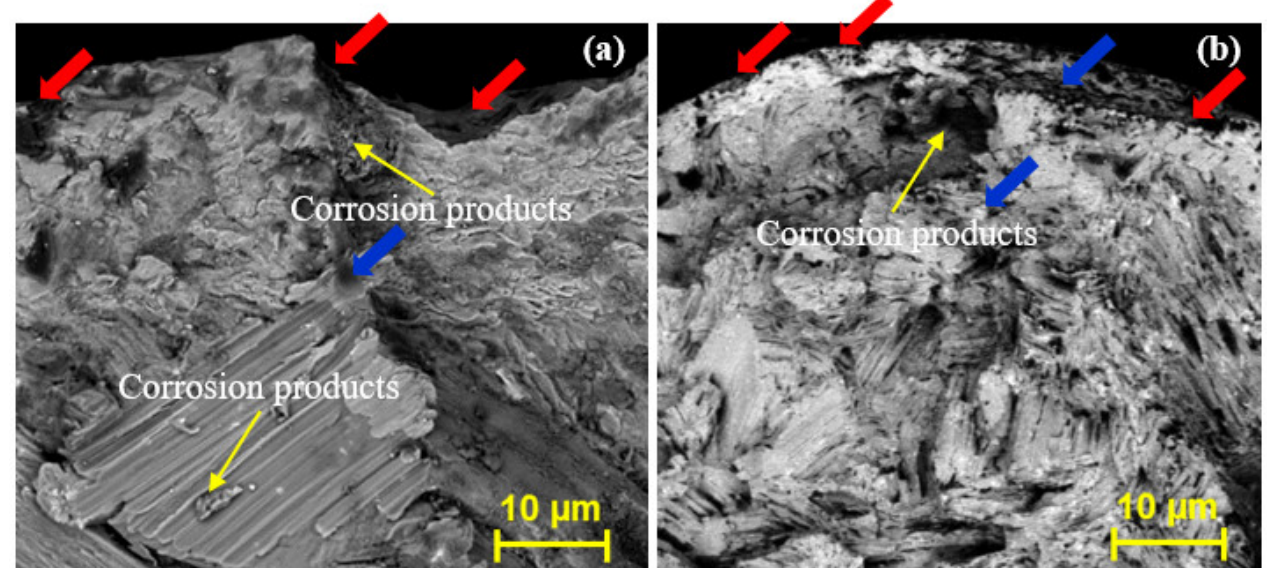
Figure 7. Fatigue fracture surfaces show the crack initiation and propagation in the ( a ) as-deposited and ( b ) heat-treated at 300 °C of the AA7075 cold spray coated AZ31b Mg alloy. Note: Red and blue arrows indicated the cossorion pits at the outer surfaces and on the fracture surface, rescectively.